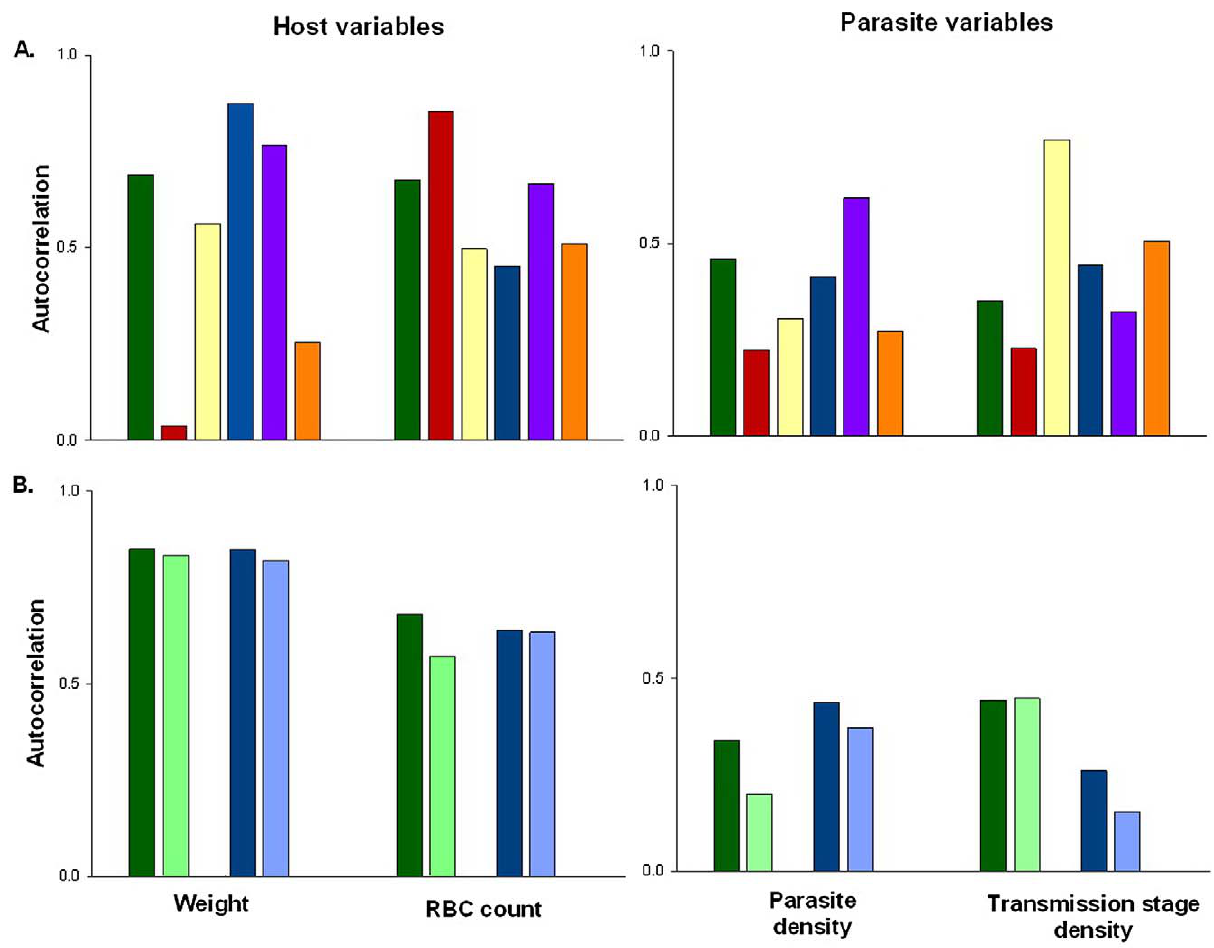
Figure 1. The extent of auto-correlation in experimental rodent malaria infections. Estimates of temporal auto-correlation in key parasite and host traits observed during daily sampling of infections initiated with controlled Plasmodium chabaudi parasite doses in mice matched for strain, age, and sex. (A) Data for days 5–15 post infection taken from [16,17]. Colours represent different wild-type parasite genotypes (green=AS, red=AJ, yellow=ER, blue=DK, purple=CW, orange=CR). (B) Data for days 3–18 post infection taken from [18] in mice with depleted levels of CD4 + T cells (light bars) or unmanipulated immune responses (dark bars) for genotypes AS (green) and DK (blue). These estimates demonstrate how levels of auto-correlation can be both high (up to 87% correlation between residuals on consecutive days) and variable between traits. The implications of this will depend on the analysis performed, but auto-correlation at such high levels has the potential to dramatically increase type 1 error rates (Figure 2).